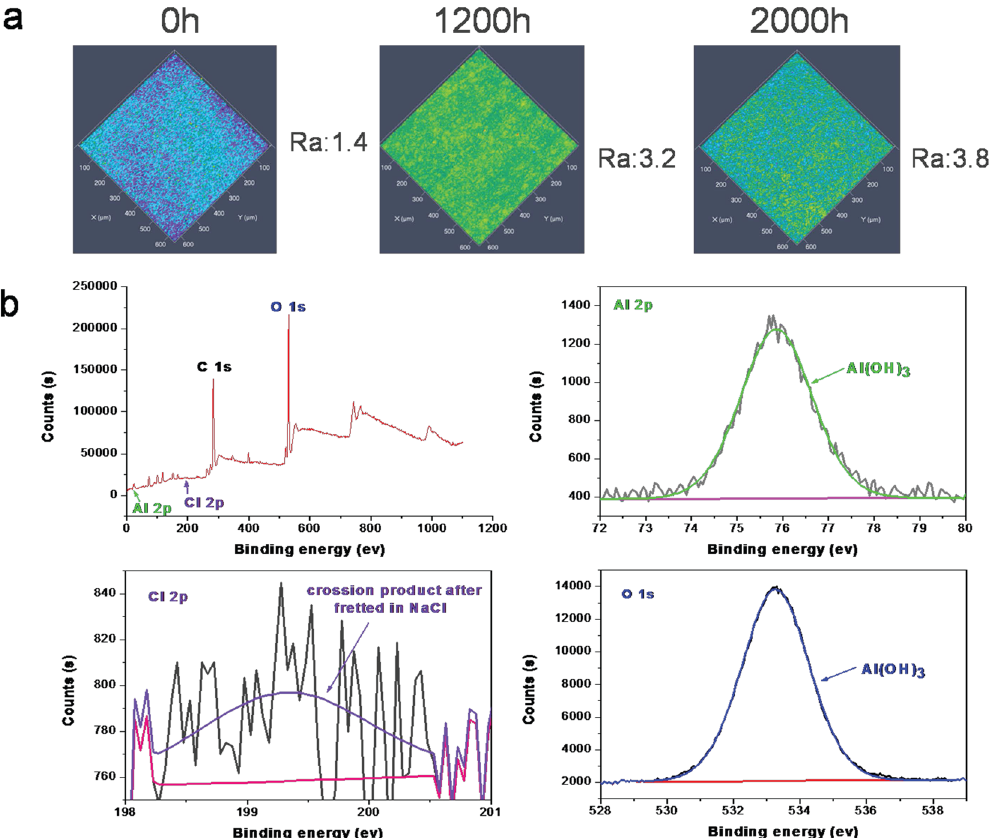
Figure 4. Surface roughness of SAOFs changed with salt spray test time and XPS analysis of corrosion product after salt spray